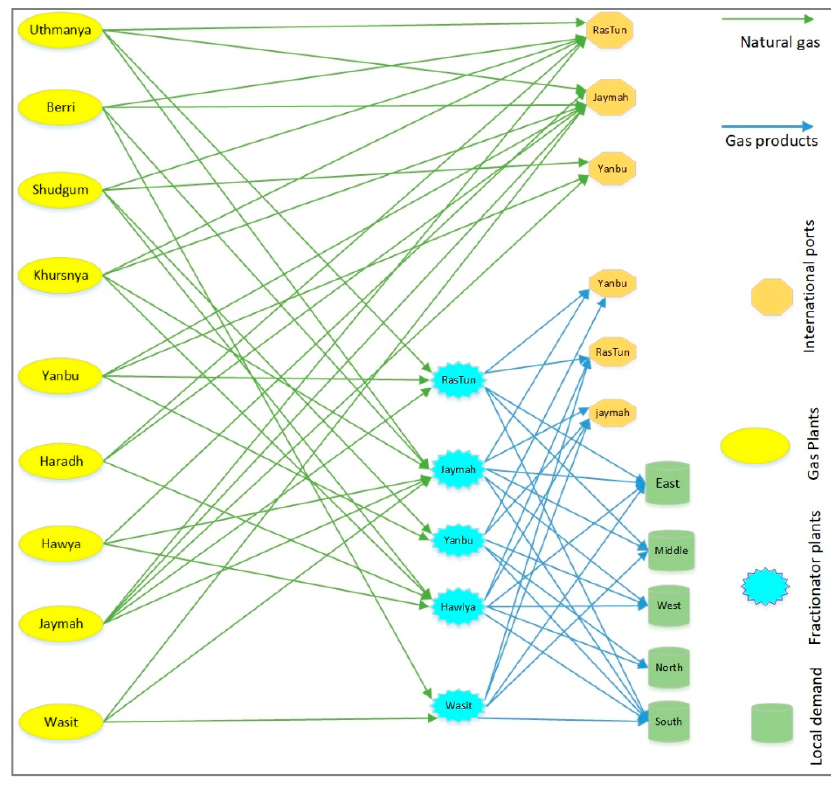
Figure 3. The natural gas network.